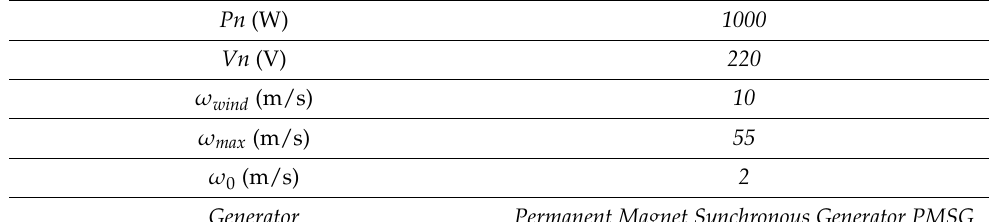
Table 7. Wind Turbine.